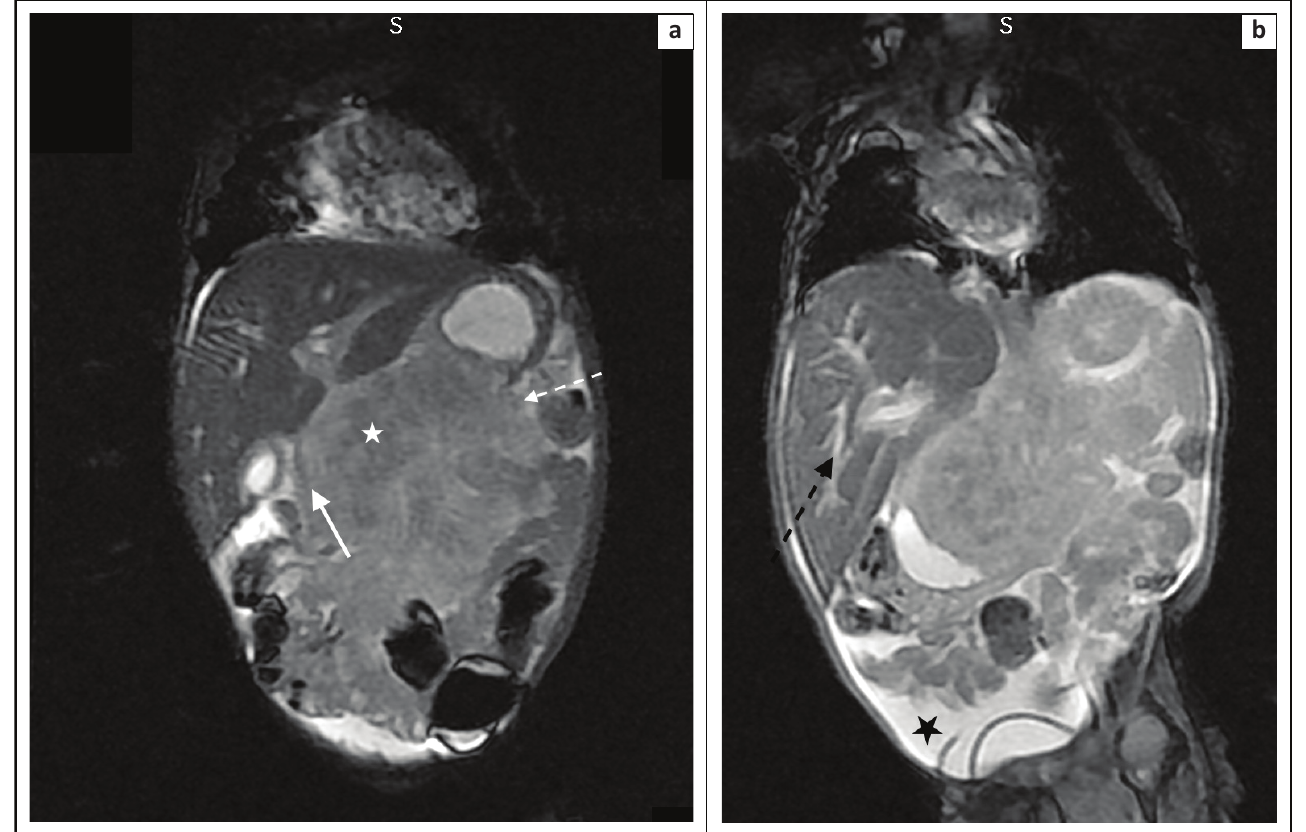
FIGURE 4: Coronal T2-weighted (T2W) magnetic resonance images: (a) Pancreatic mass (white star) with ill-defined margins and a lobulated contour (broken white arrow). Evidence of peripancreatic extension to the porta hepatis. This lesion is locally invasive, as demonstrated by the inseparability from the D2 segment of the duodenum (solid white arrow); (b) Associated findings of dilated intrahepatic bile ducts (broken black arrow) and ascites (black star).